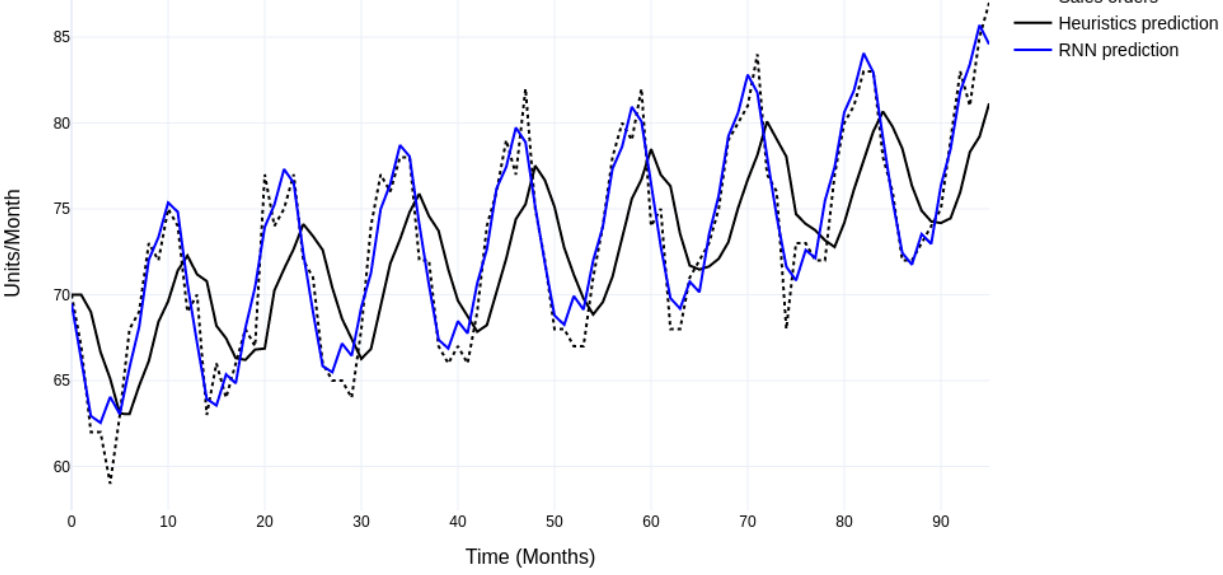
Figure 7. Comparing heuristic and RNN sales predictions.